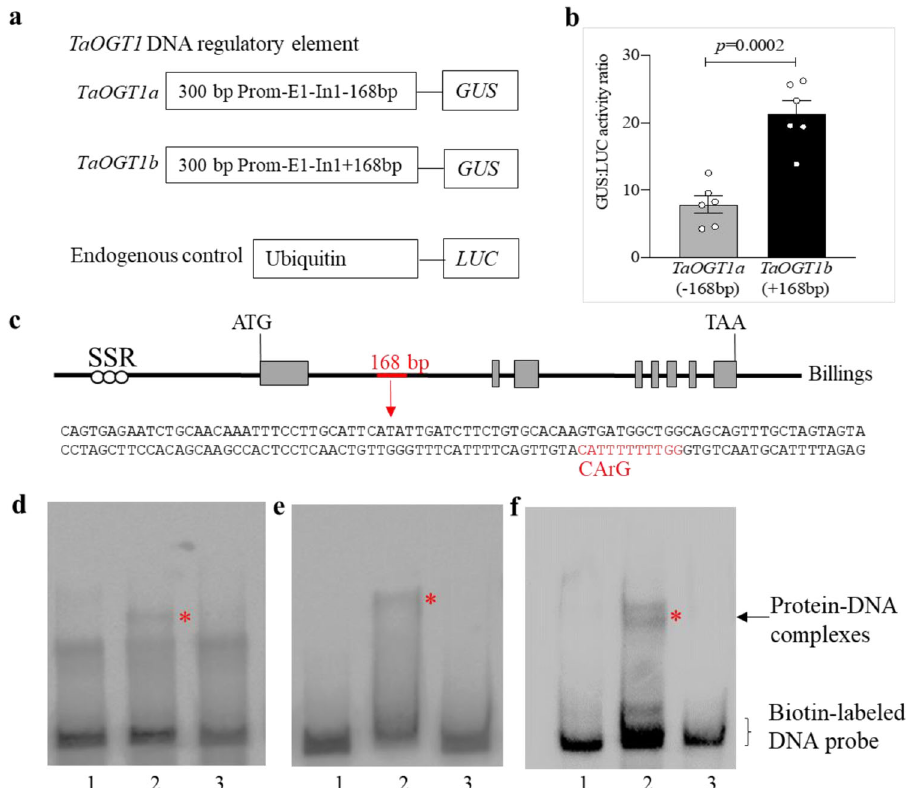
Fig. 3 Characterization of TaOGT1 . a A diagram depicting the constructs used to test regulatory elements in TaOGT1 . The promoter (Prom), exon 1 (E1), and part of intron 1 (In1) from Duster TaOGT1a without the 168-bp fragment, and from Billings TaOGT1b with the 168-bp fragment, were used as a promoter of the GUS reporter gene. The endogenous control construct was created using the Ubiquitin promoter to drive the LUC gene. b Comparison of GUS/LUC activity ratio. The GUS and LUC activities were assayed in a transient expression in wheat protoplast system. The data are presented as mean ratio ± SEM, which was calculated from six independent protoplast transformation reactions ( n = 6) for each construct. A two-tailed unpaired t test showed signi fi cant difference between the two constructs from the two TaOGT1 alleles. c The sequence of the 168-bp insertion in intron 1 of the Billings TaOGT1b allele. The CArG box is indicated in red. d – f EMSA interactions of the vrn1 and Ta VRT2 proteins with the CArG-box DNA probe labeled with biotin. EMSA was performed for the vrn1b protein from 2174 (which has the same vrn1b as Billings and Duster) ( d ), vrn1a from Jagger ( e ), and Ta VRT2 ( f ). Lane 1 indicates the biotin-labeled TaOGT1b DNA probe alone. Lane 2 represents vrn1 or Ta VRT2 protein and DNA in the EMSA reactions. Lane 3 represents vrn1 or Ta VRT2 protein and 100× protein competitors that were added to the EMSA reactions. These EMSA reactions were repeated three times. Source data underlying ( b , d – f ) are provided as a Source Data fi